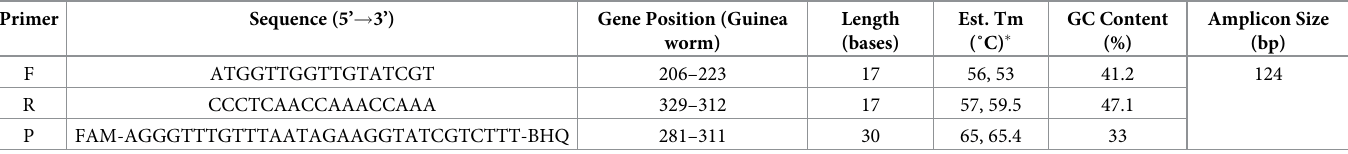
Table 1. Primers and Taqman probe targeting the mitochondrial cytochrome b ( cytb ) gene of Guinea worm ( Dracunculus medinensis) for qPCR amplification and development of a gBlock